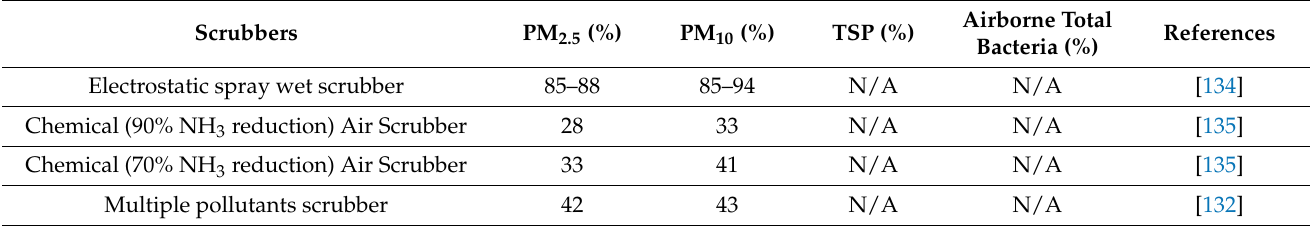
Table 12. Particulate matter and airborne bacteria reduction using